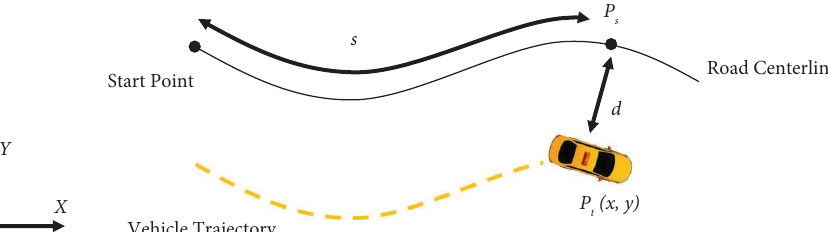
Figure 2: Conversion from global coordinate system to Frenet coordinate system.